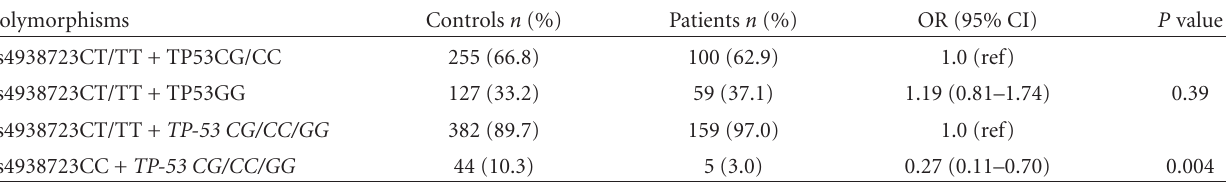
Table 3: The combined genotypes frequencies of miR-34 rs4938723 and TP-53 Arg72Pro between patients with intracranial aneurysm and controls.